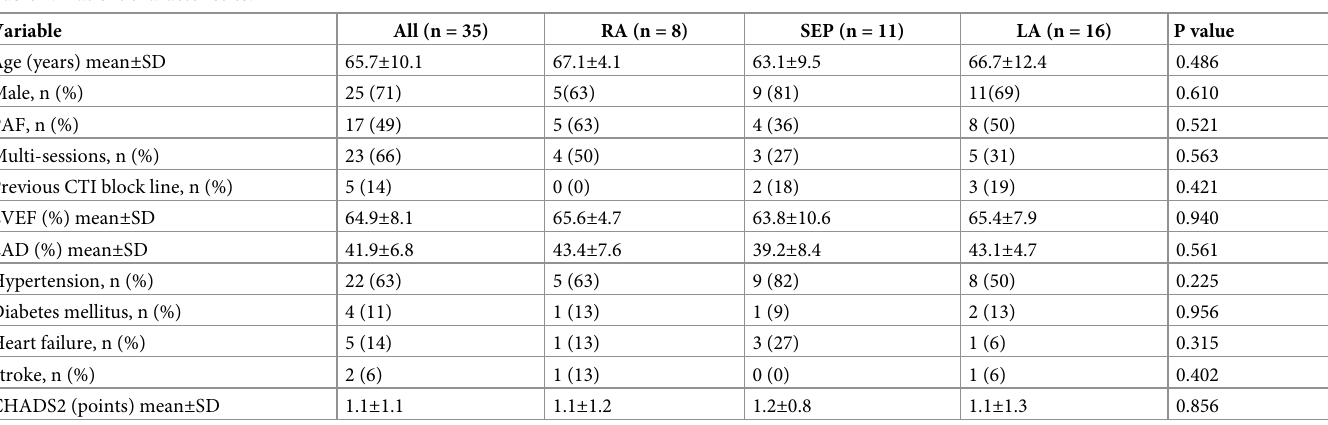
Table 1. Patient characteristics.